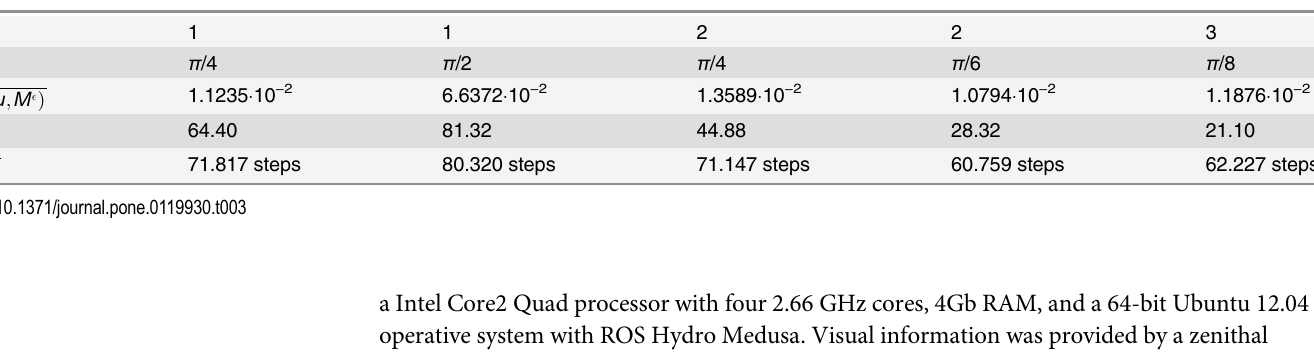
Table 3. Simulation results for different kinematic models , given as variations of linear velocity v and angular velocity ω , for (cid:2) = 10 − 2 and T = 50 time